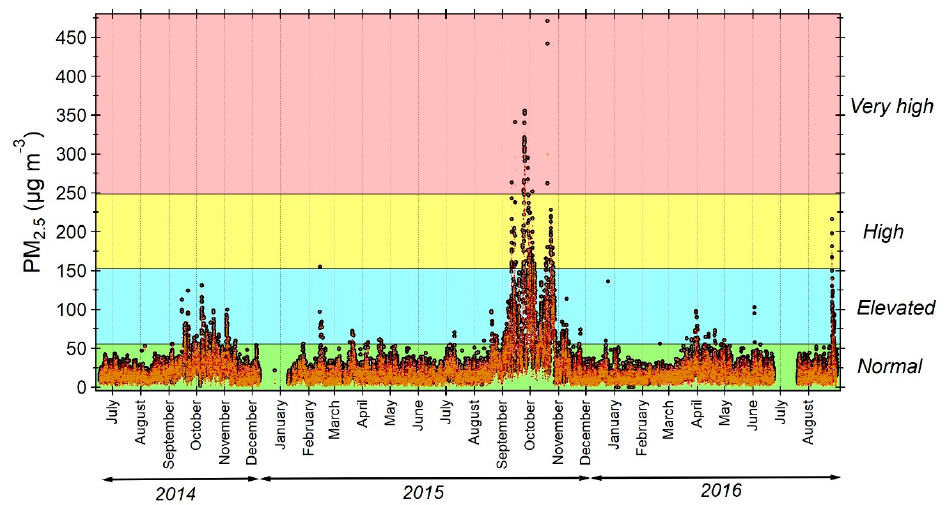
Figure 14. Time series of 1-hour PM 2.5 ambient concentration reported hourly for each of the five air quality regions of Singapore. The black dots indicate the hourly maximum concentrations in the whole island. The background colors correspond to the bands system implemented by National Environment Agency (NEA) as a guide for the public to adjust immediate activities. Data were retrieved daily from NEA air quality website [140].